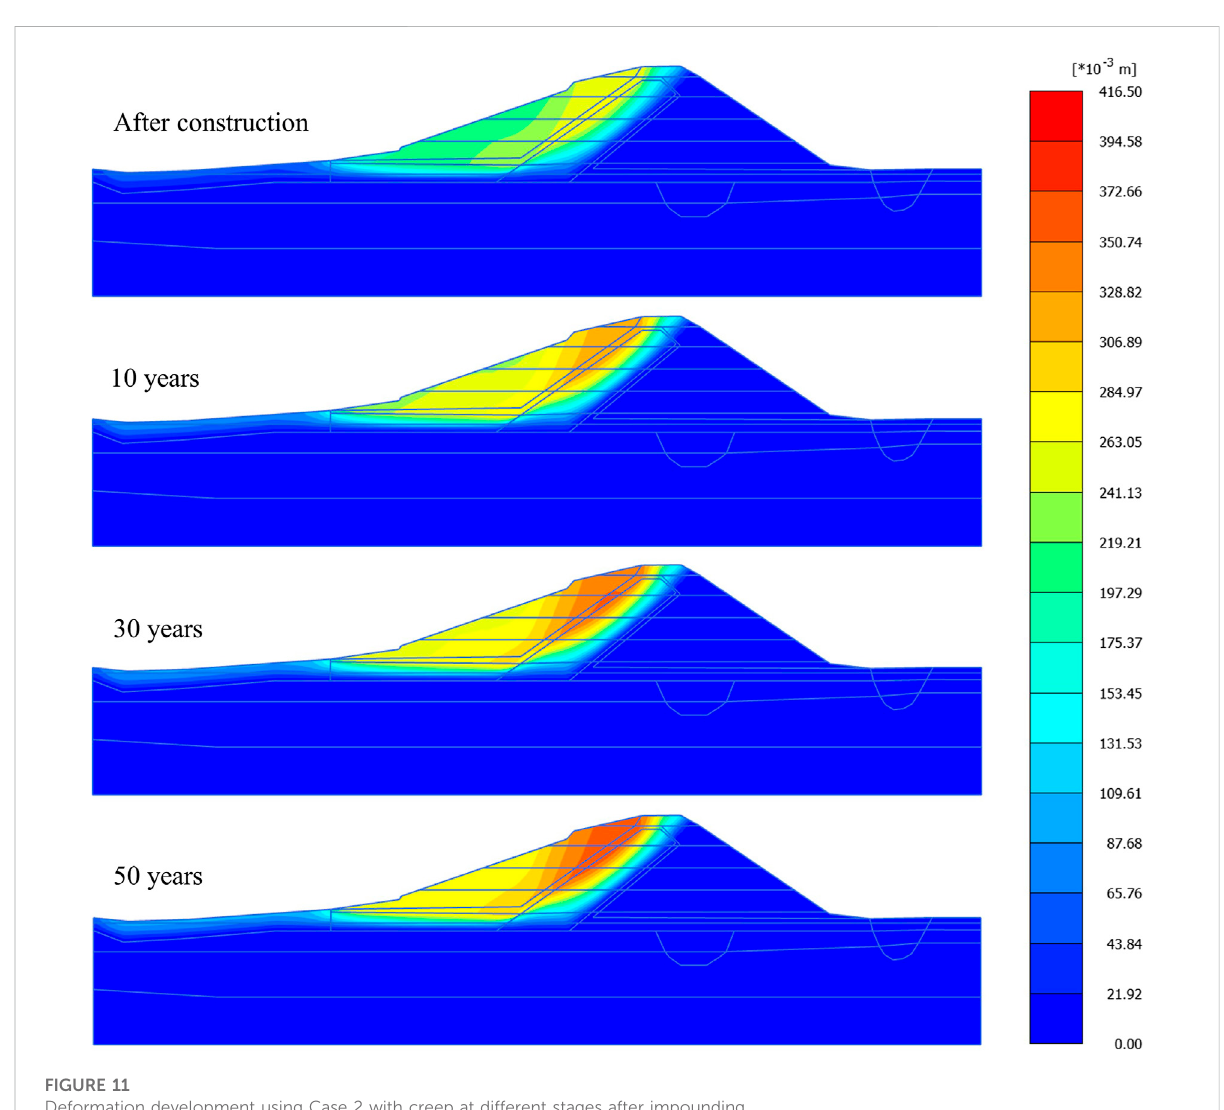
FIGURE 11 Deformation development using Case 2 with creep at different stages after